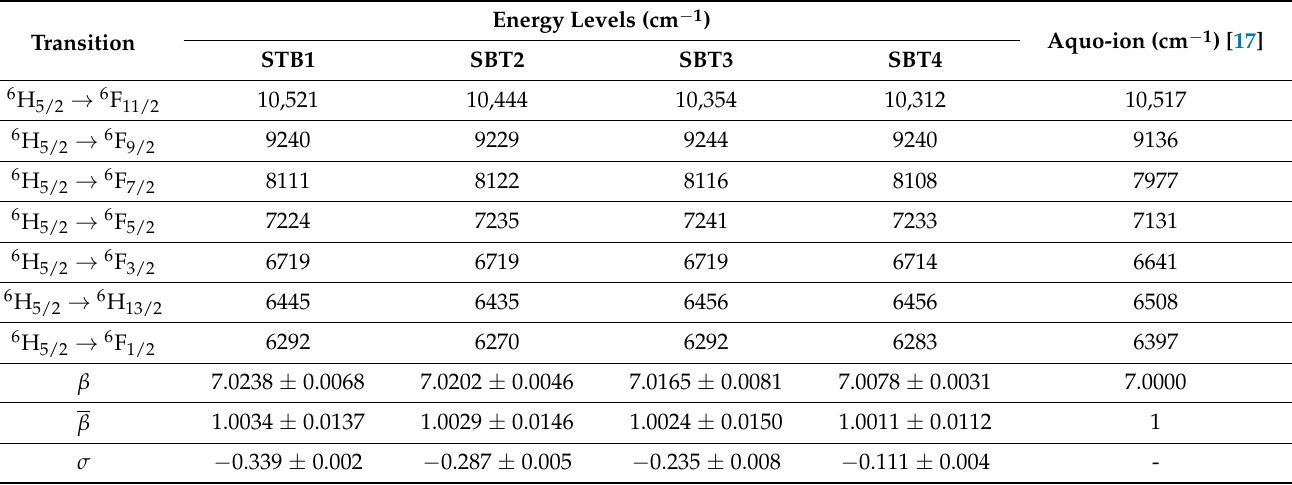
Table 3. Transition energy levels and corresponding wavenumber, aquo-ion wavenumber, nephelaux- etic effect ( β ) , and bonding